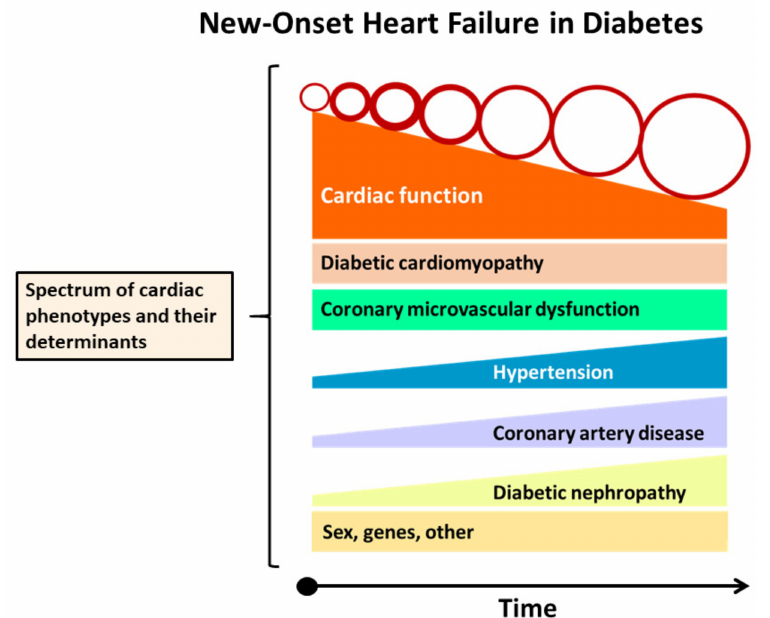
Figure 6. Spectrum of cardiac phenotypes and their determinants in new-onset heart failure (HF) in diabetes mellitus. New-onset HF in DM is a heterogeneous syndrome depending on diverse factors in which disease progression is associated with a dynamic evolution of functional and structural changes, leading to unique disease trajectories creating a spectrum of phenotypes with overlapping and distinct